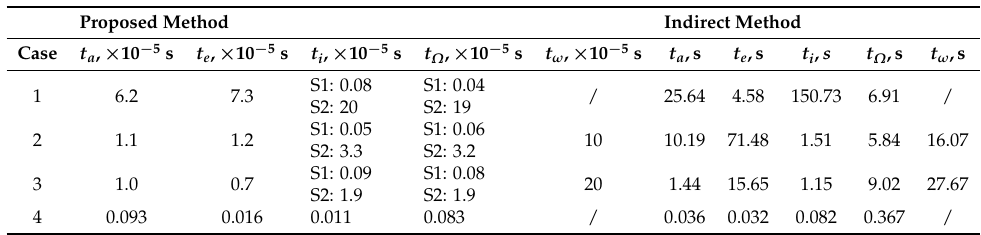
Table 3. Computational